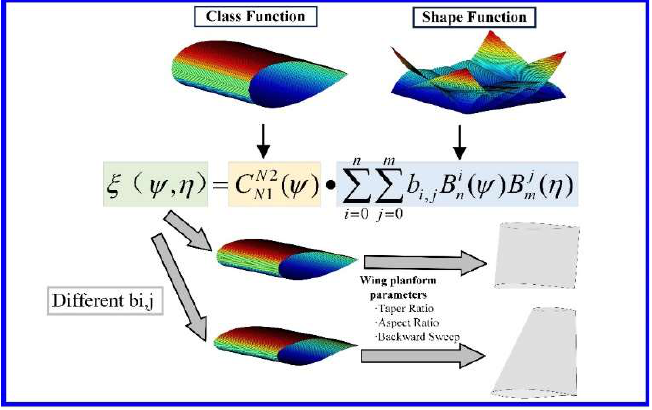
Figure A5. Three-dimensional CST parameterization process. According to Equation (A11), the number of design variables is determined by pa- rameters n and m . Figure A6 shows the wing fitting corresponding to different parame- ters. From the comparison of thickness contours, it can be observed that the fitting accu-